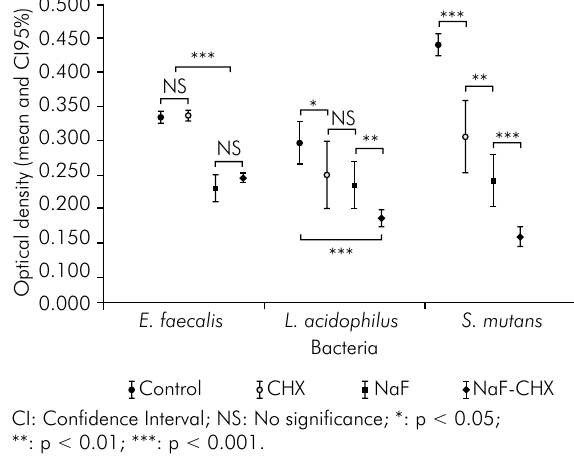
Figure 4. Effect of CHX, NaF and NaF-CHX on S. mutans, L. acidophilus and E.